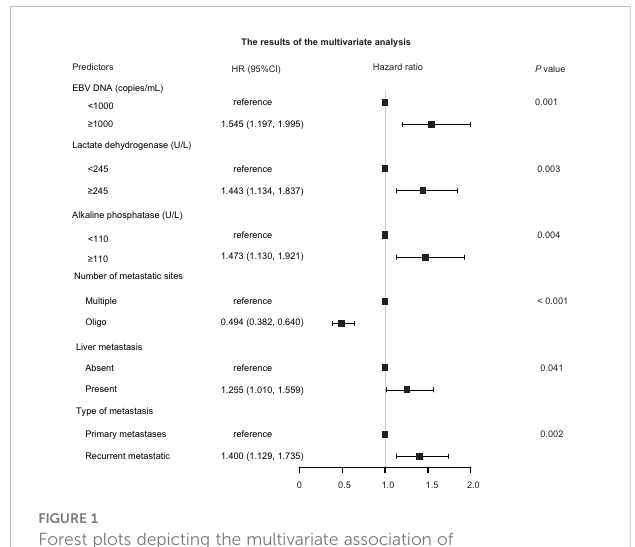
FIGURE 1 Forest plots depicting the multivariate association of clinicopathological characteristics with progression-free survival. CI, con fi dence interval; EBV, Epstein – Barr virus; HR, hazard